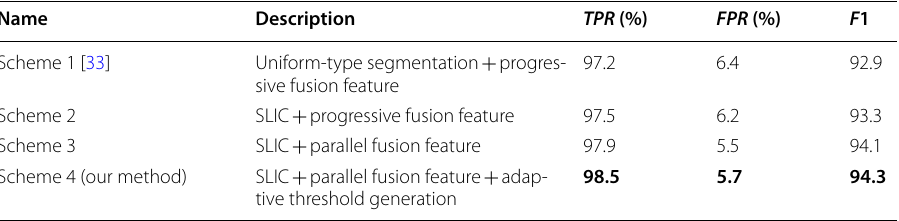
Table 5 Detection results of different schemes with different module combination